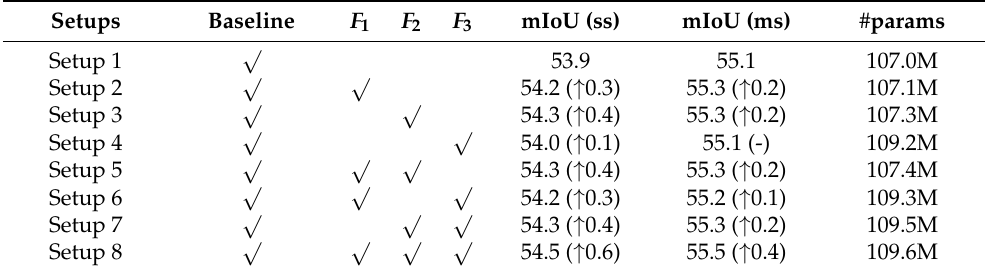
Table 1. Performance comparison of different auxiliary CNN setups using the ADE20K validation set. baseline: Mask2Former with Swin-B backbone for semantic segmentation. F l : feature embeddings extracted at the l th stage from the Swin-B backbone. ss: single-scale. ms: